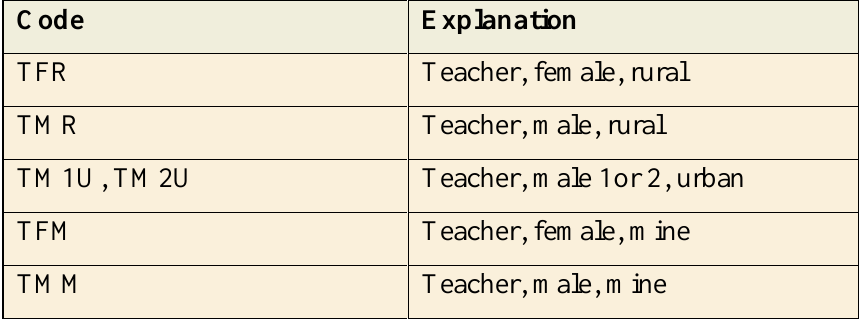
Table 5.2: Codes of individual interviews: teachers